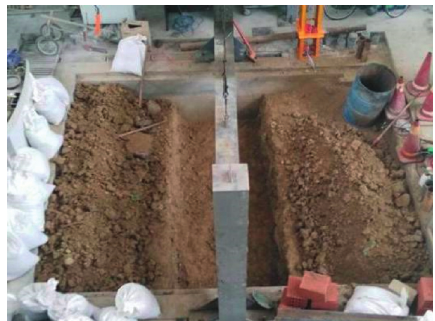
Figure 7: The site of the physical model.